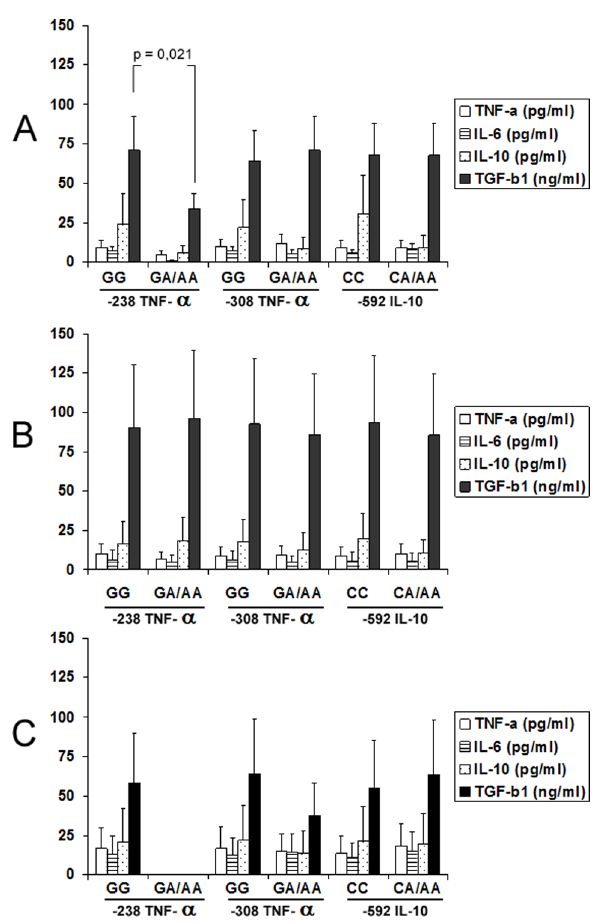
Figure 1. Serum concentrations of tumor necrosis factor- a (TNF- a ) (white bars), interleukins 6 (IL-6) (lined bars) and 10 (IL- 10) (dotted bars) and transforming growth factor beta 1 (TGF- b 1) (black bars) in healthy controls (A) and in HIV-HCV coinfected patients with chronic hepatits (B) (n=50) or liver cirrhosis (C) in function of the polymorphisms of -238 and -308 TNF- a and -592 IL-10 promotor genes.